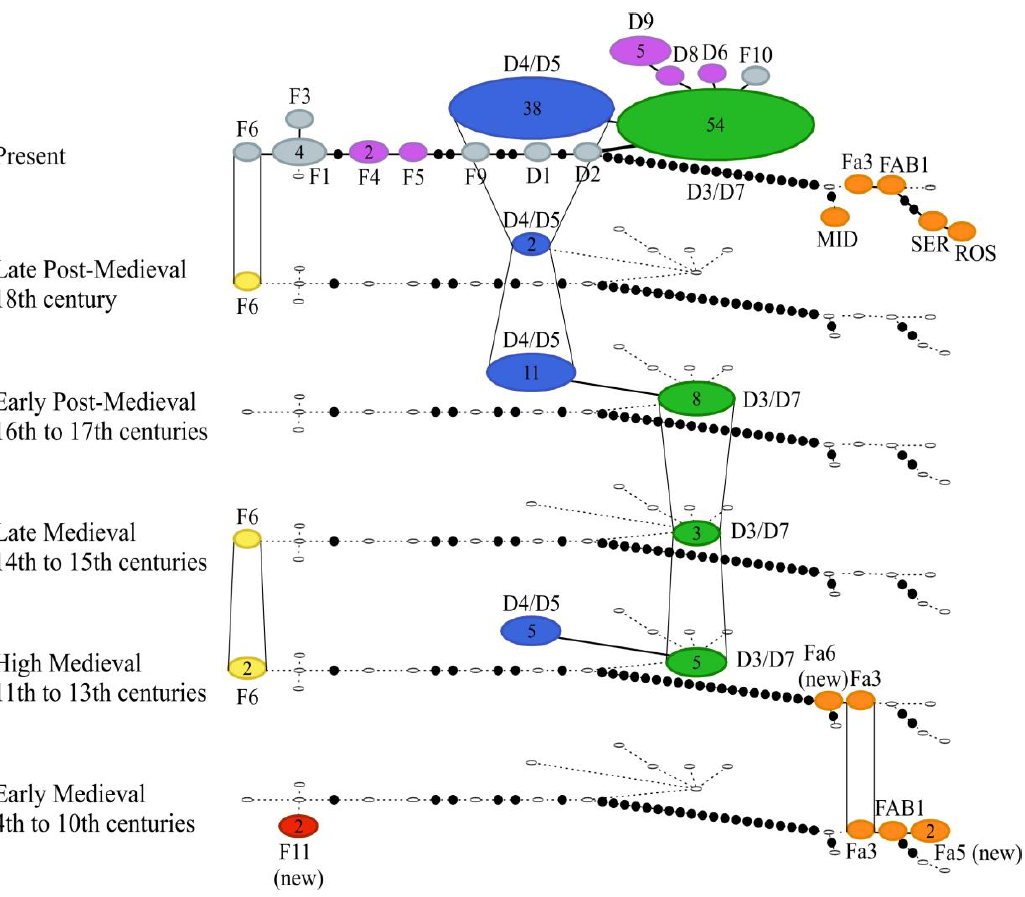
Figure 4. Temporal statistical parsimony network of the concatenated hypervariable part of the mitochondrial control region (204 bp) of subfossil goose samples from Russia from the 4th to 18th century CE and modern greylag goose ( Anser anser ) haplogroups D and F. These groups contain the known domestic goose haplotypes D3 and D7 (green), D4 – D5 (blue), and D6, D8 – D9, and F4 – F5 (purple), and the wild greylag goose in grey color in the depiction for the Present Period. Selected modern bean goose ( Anser fabalis ) haplotypes are also shown separated by at least 21 mutational steps from the others (orange color). MID, SER, and ROS denote the subspecies Anser fabalis middendorffii , Anser fabalis serrirostris , and Anser fabalis rossicus, respectively, while FAB and Fa denote Anser fabalis fabalis haplotypes. The size of each ellipse is proportional to the frequency of each haplotype and the number of individuals greater than one are indicated with a number within the ellipse. Small white ellipses indicate haplotypes absent in that time period. Number of black dots +1 connecting haplotypes equals to nucleotide differences.